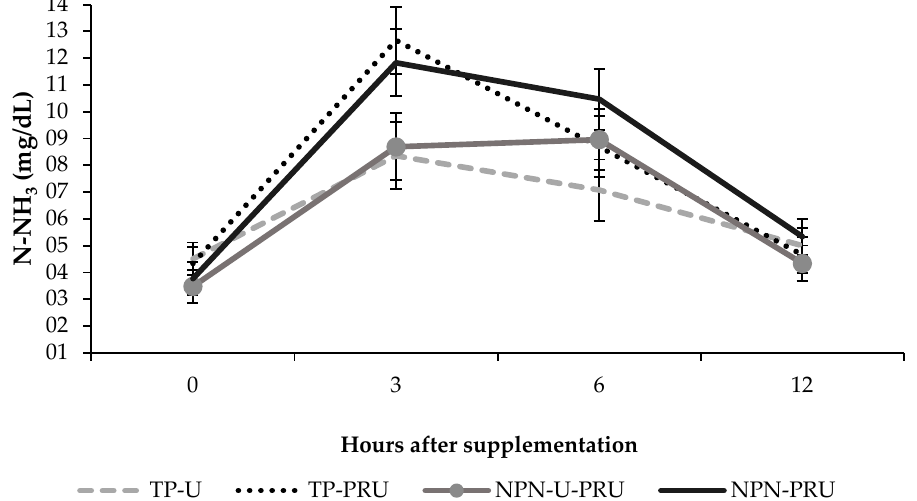
Figure 1. Ammoniacal nitrogen at different times after Nellore cattle receiving different types of supplementation in Urochloa brizantha cv. Marandu during the seasonal period.